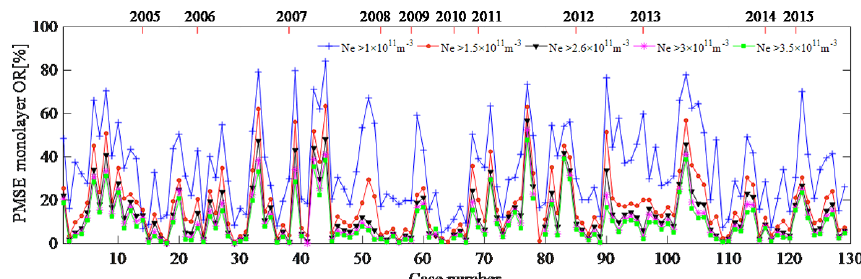
Figure 5. PMSE monolayer occurrence ratio under different electron density thresholds, with the axis at the top showing the time in years.